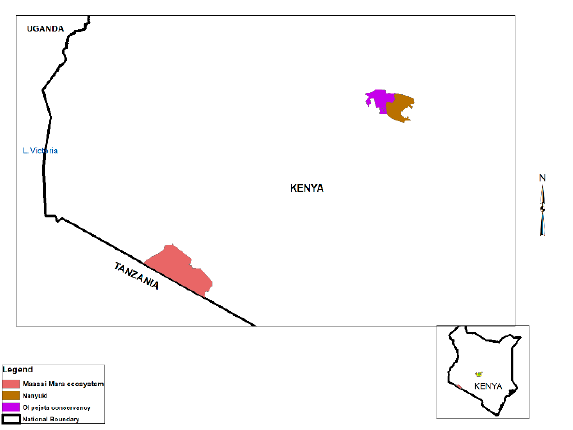
Figure 1. Map of Kenya showing the location of study area and Crimean-Congo hemorrhagic fever (CCHF).